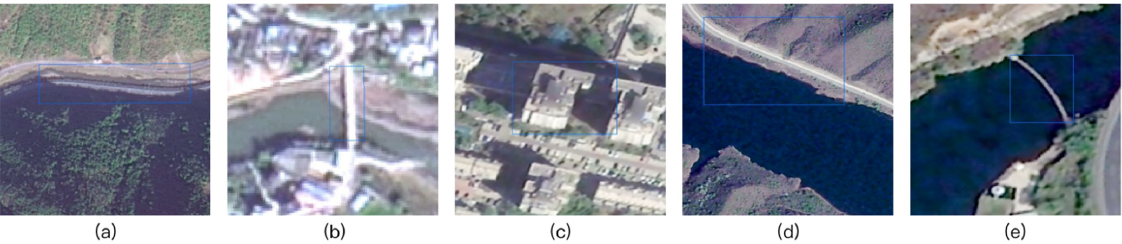
Figure 16. False positives in Yangbi ( a , b ) and Changping ( c – e ): ( a ) riverbank, ( b ) bridge, ( c ) building, ( d ) levee, and ( e ) bridge.